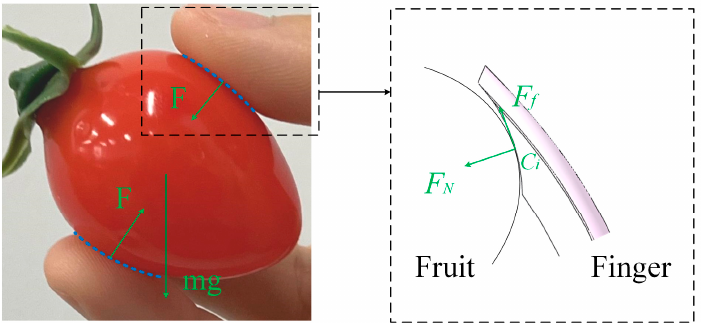
Figure 7. The feasibility analysis of gripper gripping. Note: arrows and dashed lines say finger designs are inspired by hand grips.